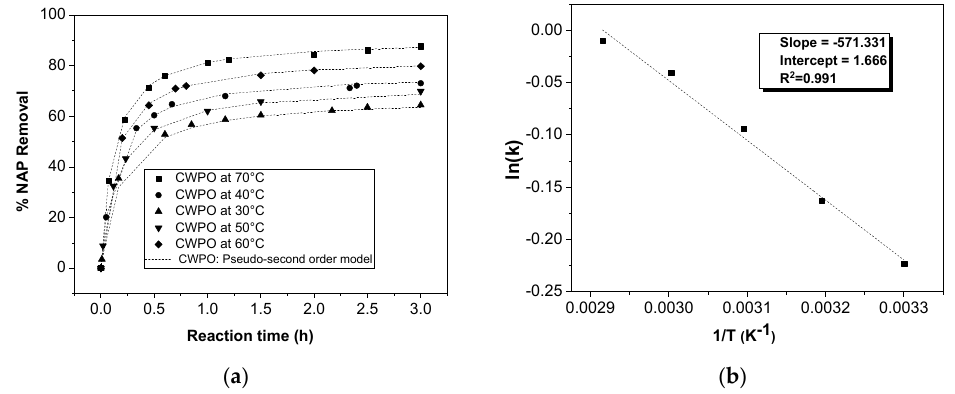
Figure 5. ( a ) Modeling of experimental data by pseudo-second-order kinetic model (at five different temperatures); ( b ) Arrhenius plot for CWPO experiments of NAP ([NAP] 0 = 10.0 mg/L, pH = 5.0, [catalyst] = 1.0 g/L, [H 2 O 2 ] 0 = 1.5 mM).